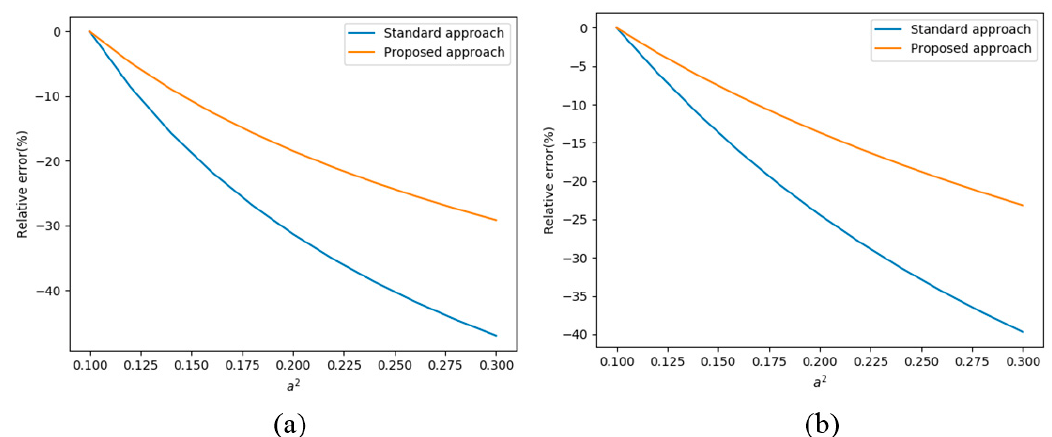
Figure 5. ( a )The variation of the relative error defined above with respect to the size of the right inclusion, a 2 , with underestimation ε = 40%. ( b ) The variation of the relative error defined above with respect to a 2 with ε = 20% .